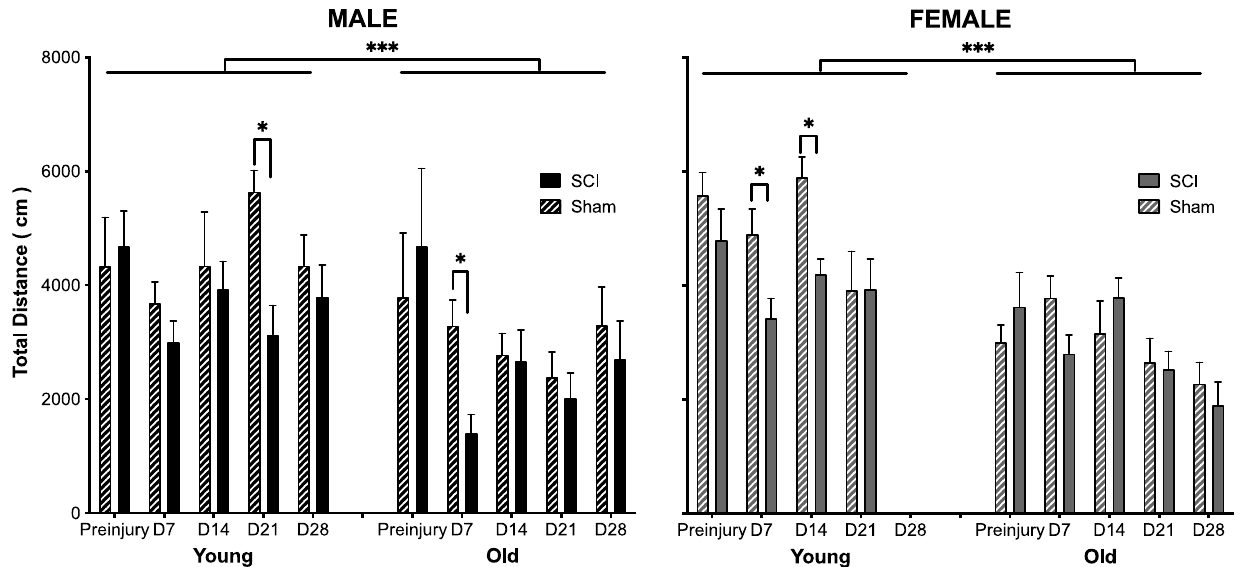
Figure 2. Age, sex and SCI affected open field activity. The young mice displayed greater activity in the open field than the old mice, with females also displaying increased activity relative to males. Not surprisingly, there was a main effect of SCI on activity. SCI reduced activity relative to sham controls, particularly in the early stage of injury (Day 7), irrespective of the demographic observed. Days (D) post injury are denoted on the x-axis, with the mean (±SEM) distance traveled in 10 min depicted on the y-axis. n= 4 sham and 5 SCI old males; 4 sham and 11 SCI young males; 8 sham and 7 SCI old females; 7 sham and 8 SCI young females. *** p < 0.0001 and * p < 0.01.